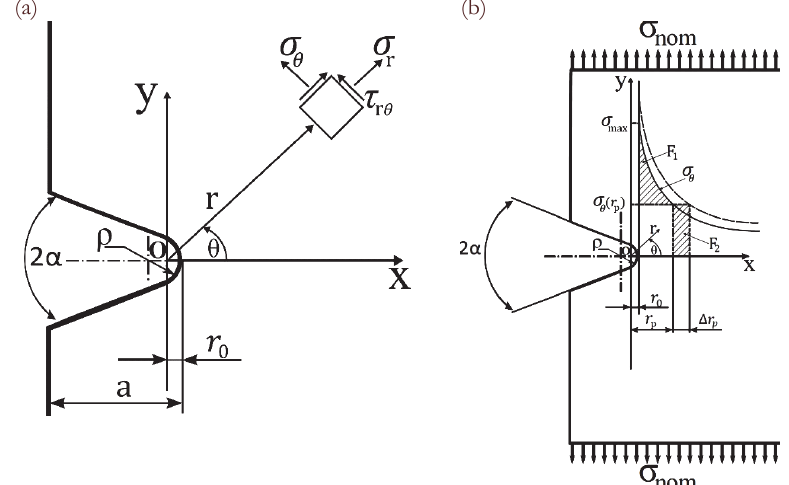
Figure 1: (a) Coordinate system and symbols used for the stress field components in Lazzarin-Tovo equations; (b) coordinate system and symbols used for the elastic stress field redistribution for blunt